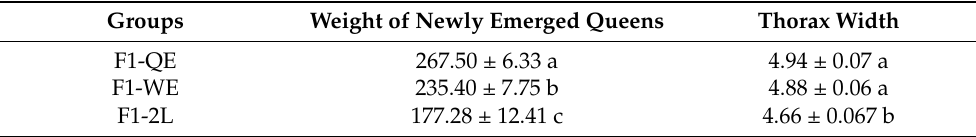
Table 2. Weight and thorax width of F1